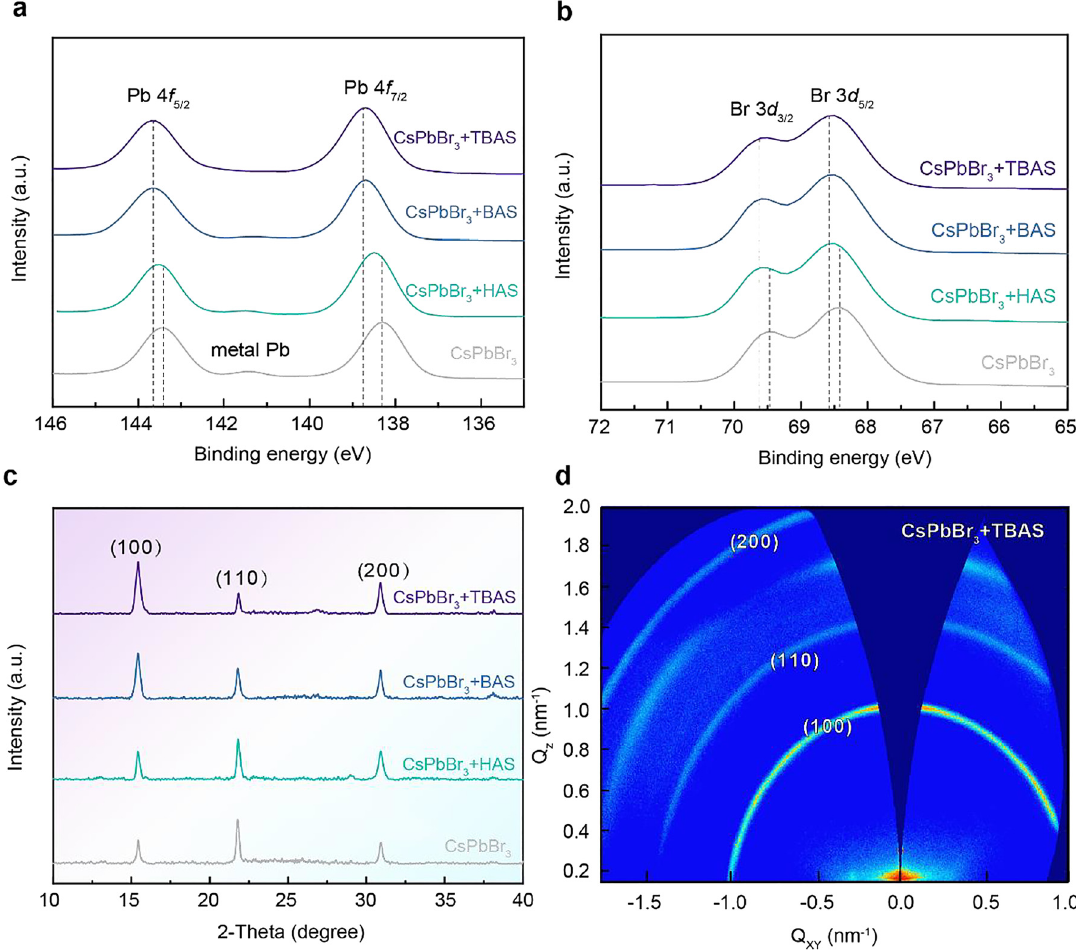
Figure 2: Structural characterizations of the CsPbBr 3 perovskite fi lms. (a) Pb 4 f , (b) Br 3 d X-ray photoelectron spectroscopy (XPS) spectra, and (c) X-ray diffraction (XRD) patterns of the original CsPbBr 3 fi lm and CsPbBr 3 fi lms incorporated with hexanoic acid sodium salt (HAS), benzoic acid sodium salt (BAS), and 4-(tri fl uoromethyl) benzoate acid sodium salt (TBAS). (d) Grazing-incidence wide-angle X-ray scattering (GIWAXS) pattern of the TBAS-containing CsPbBr 3 fi